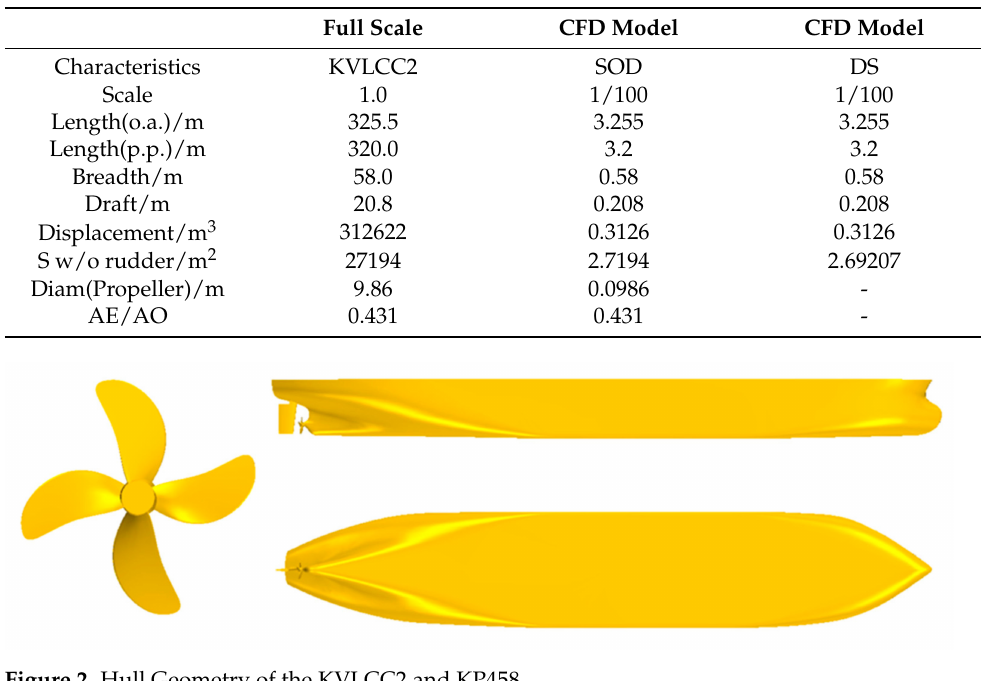
Figure 2. Hull Geometry of the KVLCC2 and